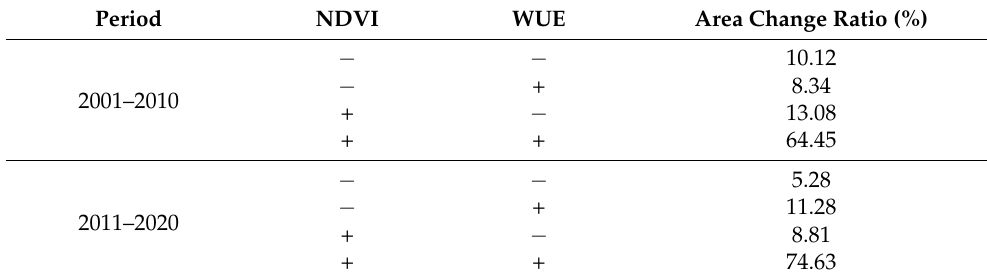
Table 4. The changes of NDVI and